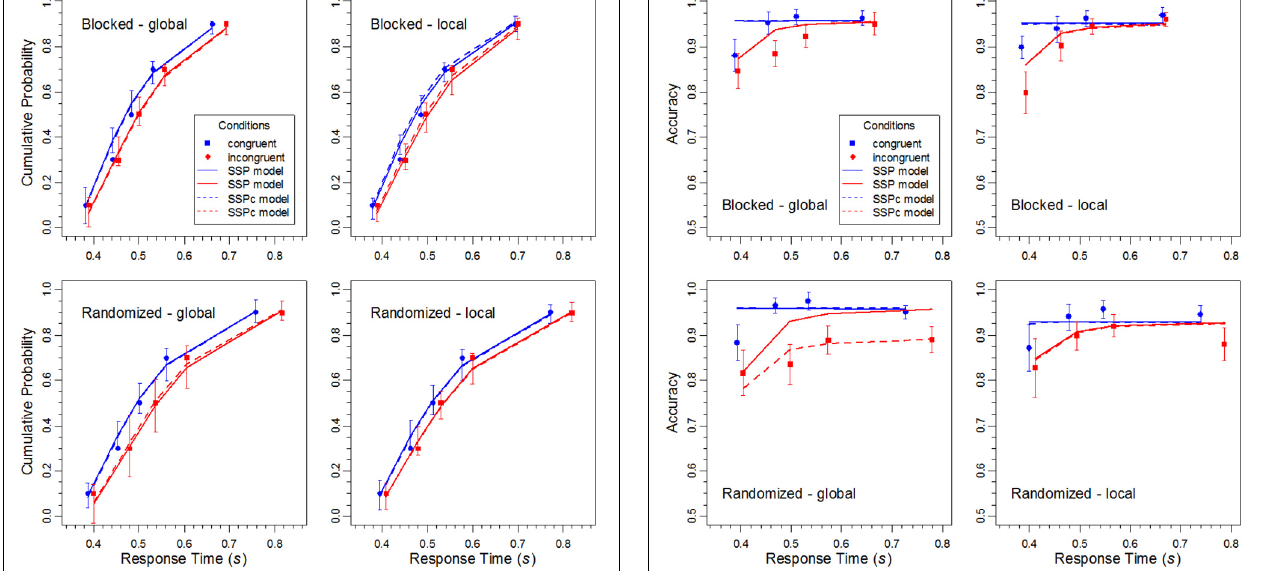
FIGURE 7 | The data points represent the conditional accuracy functions for the different conditions in the experiment, and the error bars show the respective 95%-confidence intervals. The solid and dashed lines represent the performance of the SSP model and SSPc model,